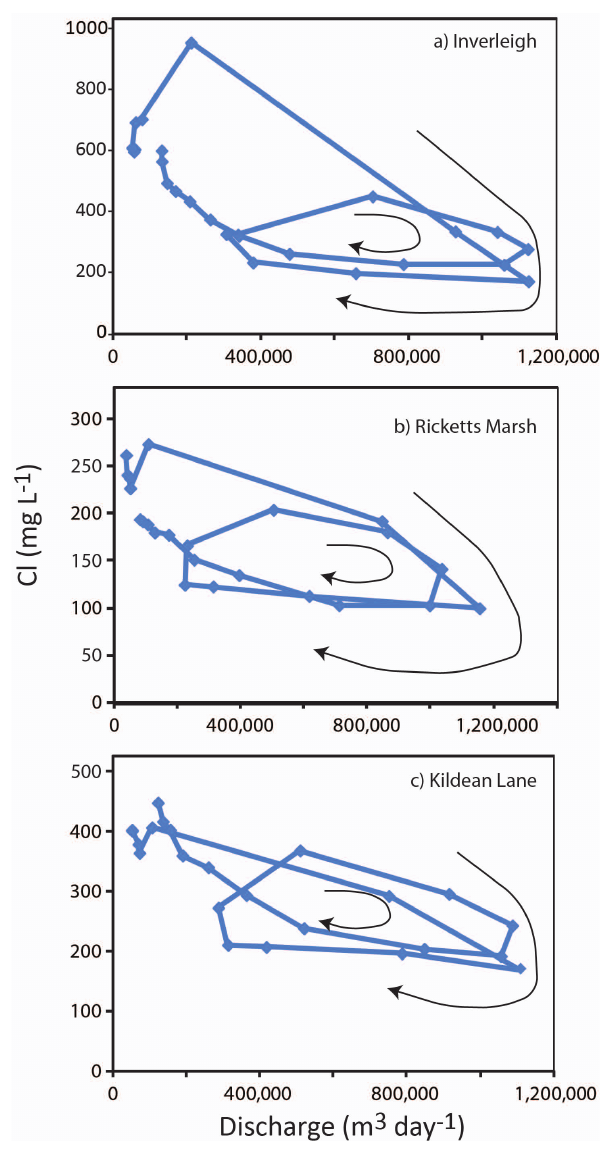
Fig. 9. Cl concentrations vs. discharge hysteresis loops for dis- charge events on days 170–200 in 2002 at Inverleigh, Ricketts Marsh, and Kildean Lane (Fig. 1); arrows show changes with time. This event corresponds to event 2 on Fig. 4.